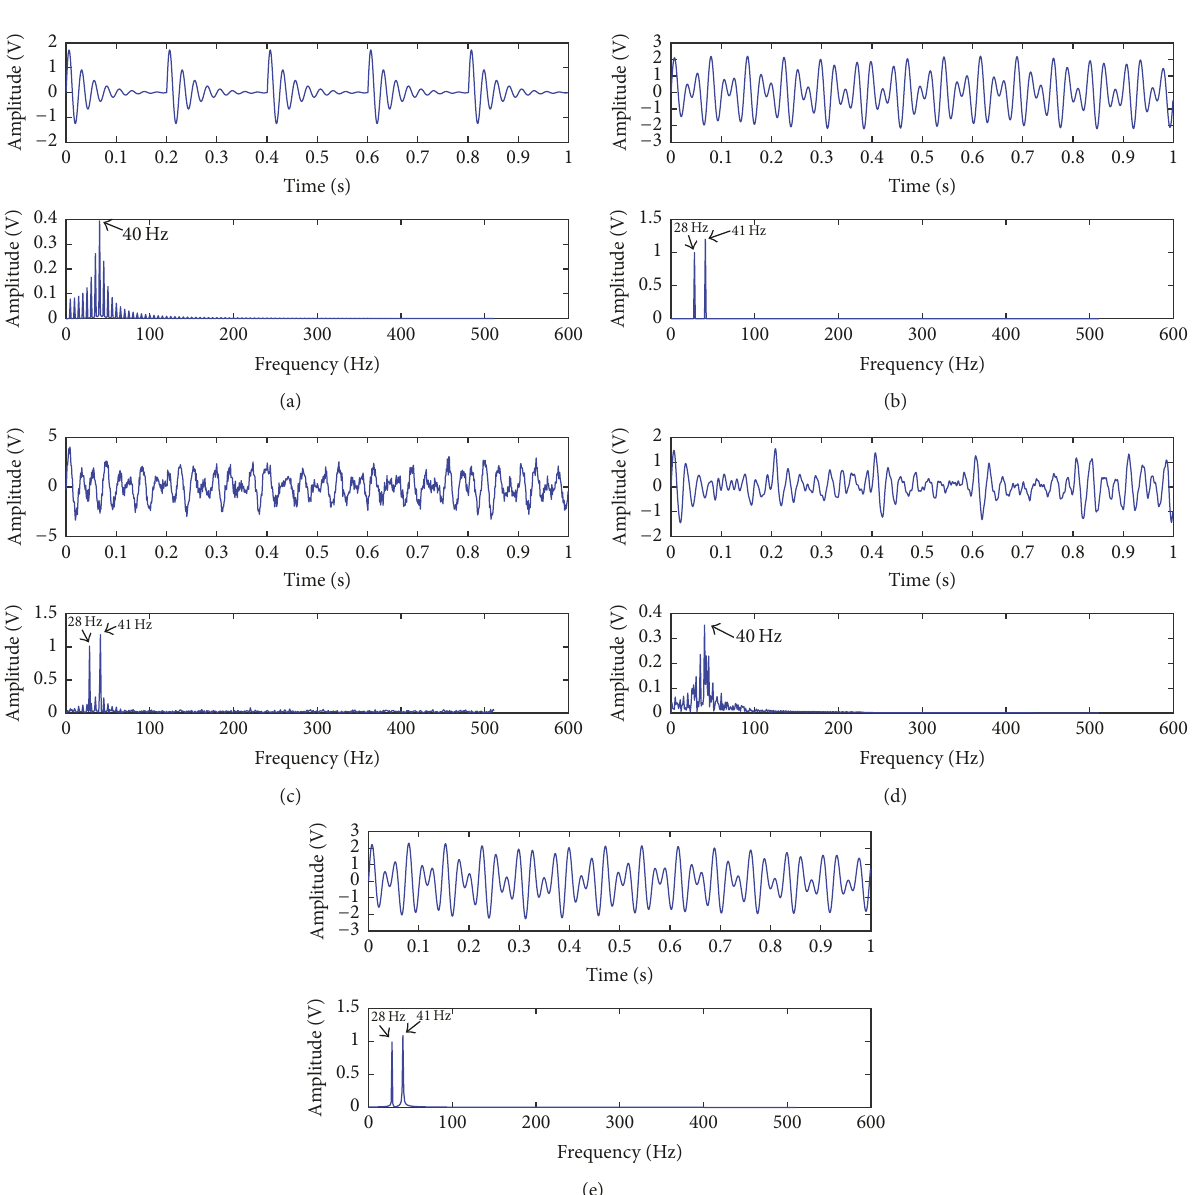
Figure 5: Simulated signal analysis results from the EOMP method: (a) waveform and FFT spectrum of the simulated signal 𝑆 1 (𝑡) , (b) waveform and FFT spectrum of the simulated signal 𝑆 2 (𝑡) , (c) waveform and FFT spectrum of the simulated signal 𝑆(𝑡) , (d) waveform and FFT spectrum of the extracted signal 𝑆 1 (𝑡) , and (e) waveform and FFT spectrum of the extracted signal 𝑆 2 (𝑡) .